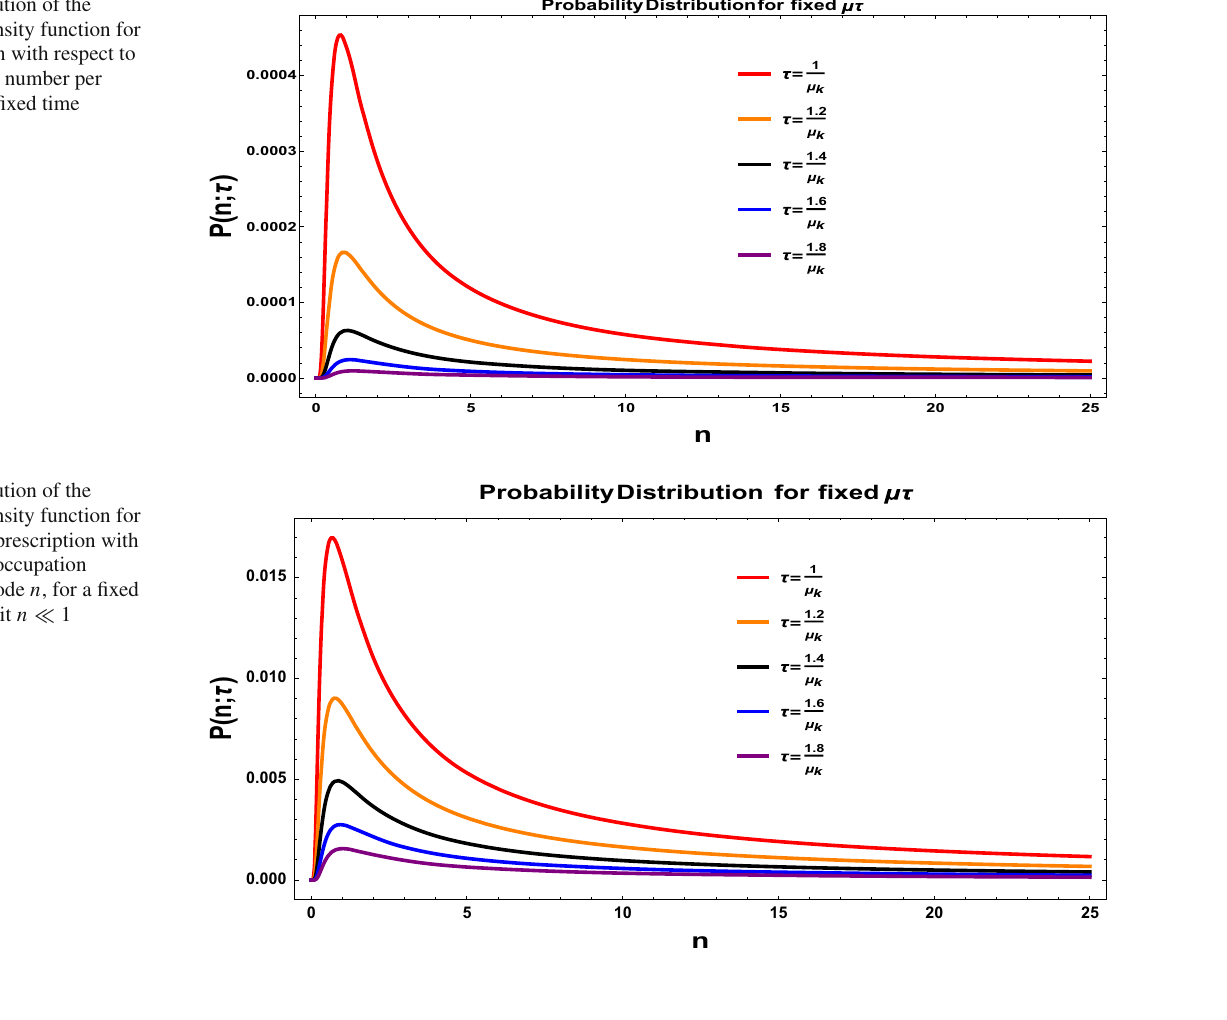
Fig. 55 Evolution of the